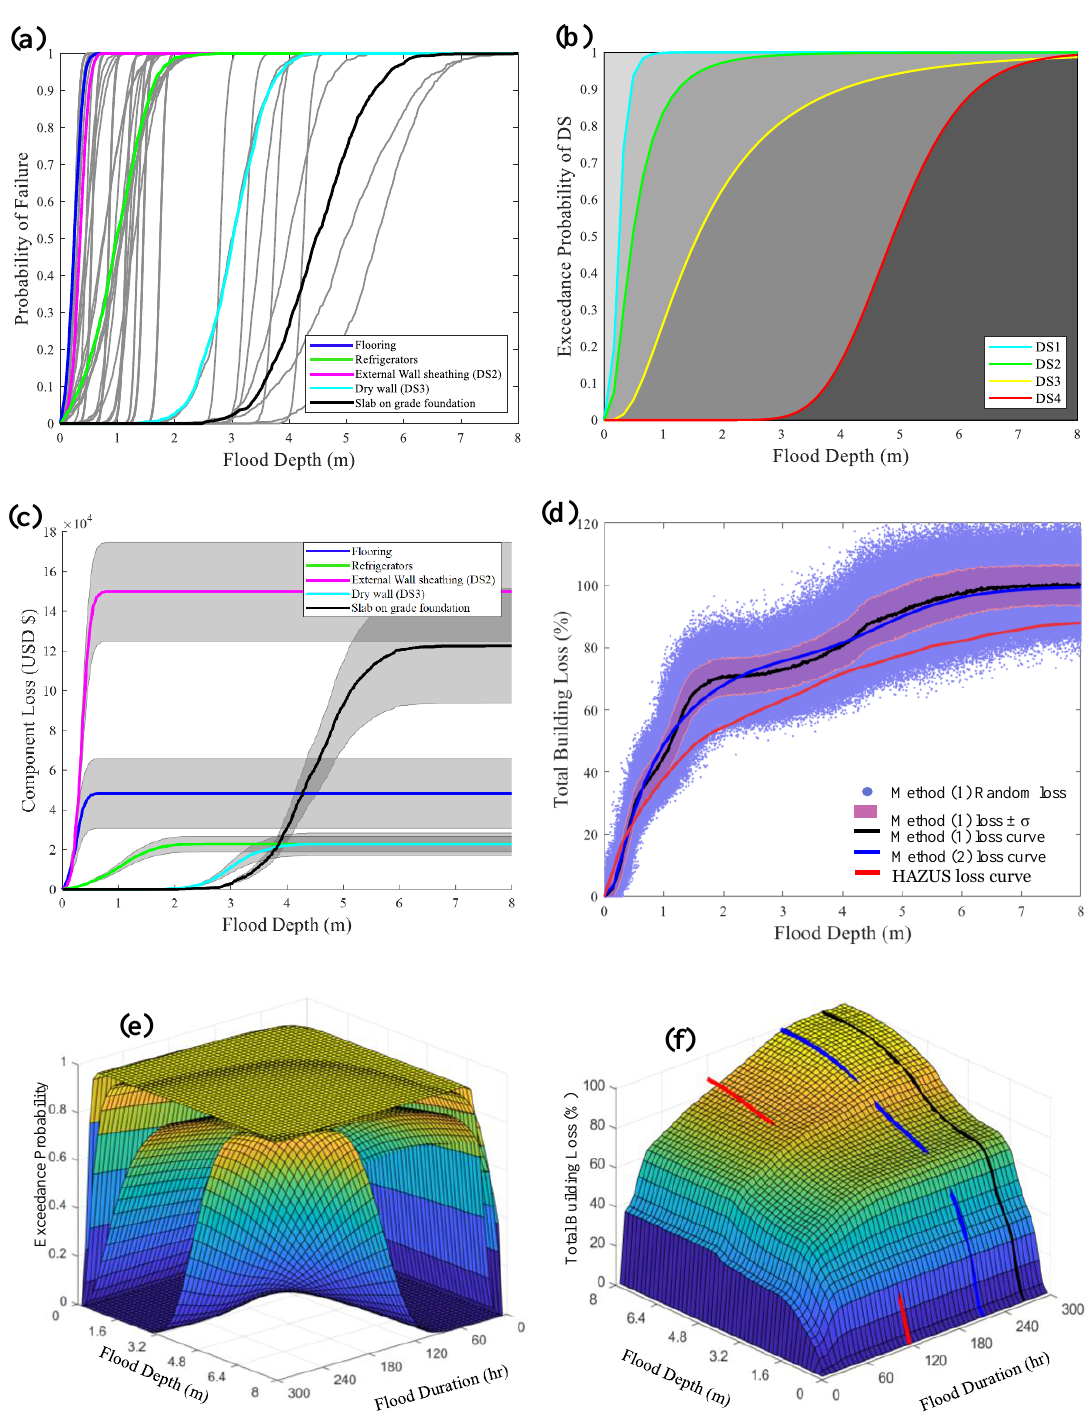
Figure A21. F7 archetype analysis results: ( a ) Component fragility curves; ( b ) Building fragility curves; ( c ) Selected components’ loss curves; ( d ) Building loss curves; ( e ) Building fragility surfaces; ( f ) Building loss surface.